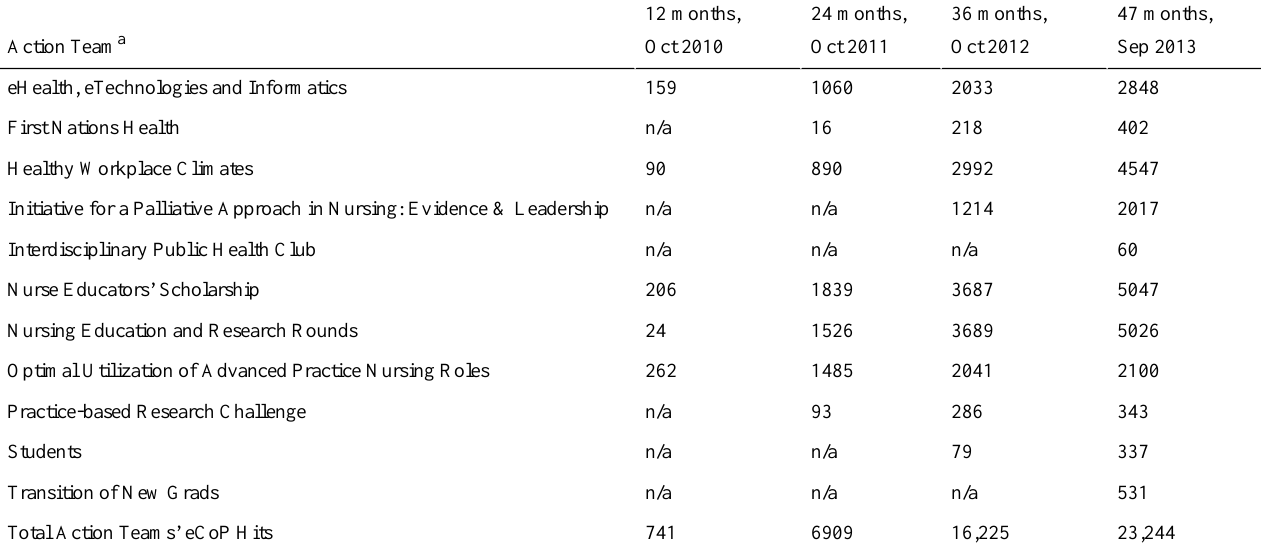
Table 2. Cumulative hits for Action